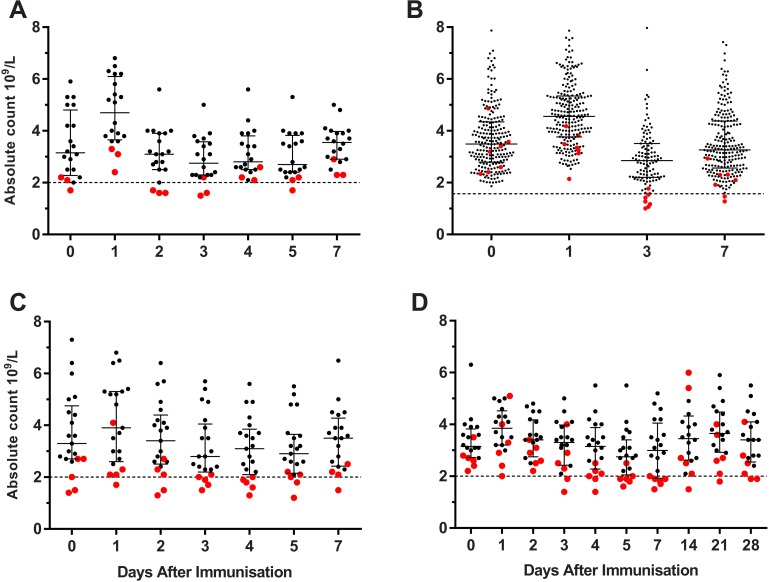
Absolute neutrophil count at different time points after vaccination on day 0.(A & B) adjuvanted seasonal TIV. (C) seasonal TIV. (D) attenuated live yellow fever vaccine. (A, C & D) conducted as inpatients. (B) conducted as outpatients. Red dots indicate subjects who had an absolute neutrophil count less than laboratory normal range on at least one time point after vaccination. Bars indicate median and interquartile range.